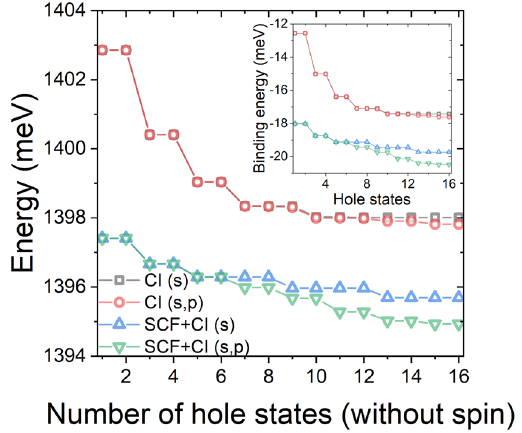
Figure 4. The ground exciton state for a CPQD of H = 4 nm and D = 23.5 nm, calculated in different approximations and as a function of hole states included in the CI modeling. The inset shows the exciton binding energy. (s) and (p) refer to a number of electron states, 1 and 3 respectively (2 and 6 with spin), included in the CI calculation. Each hole state is actually a pair of spin (Kramers) degenerate states.